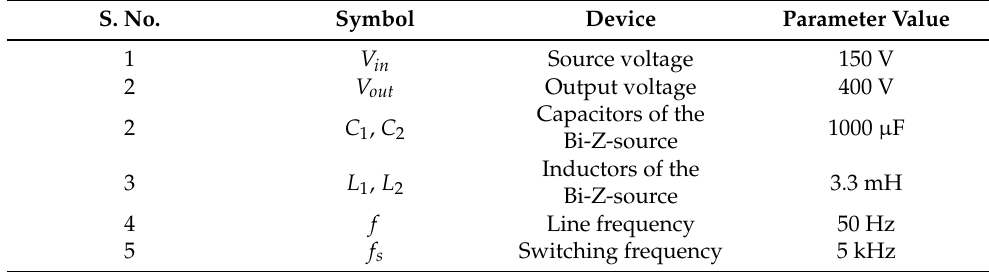
Table 2. Design Parameters of the Bi-ZSI. S.